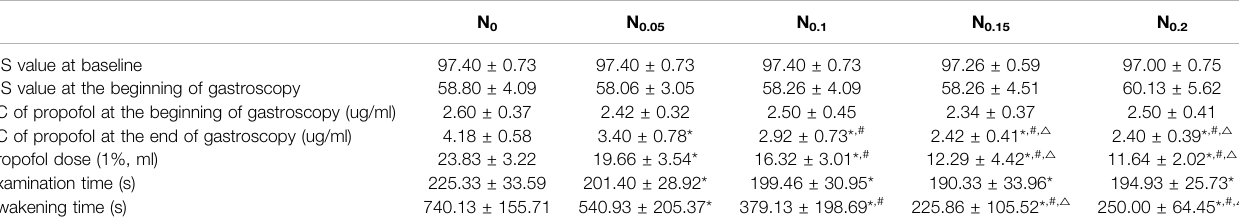
TABLE 3 | Comparison of the BIS value, propofol dose, examination time, and awakening time in fi ve